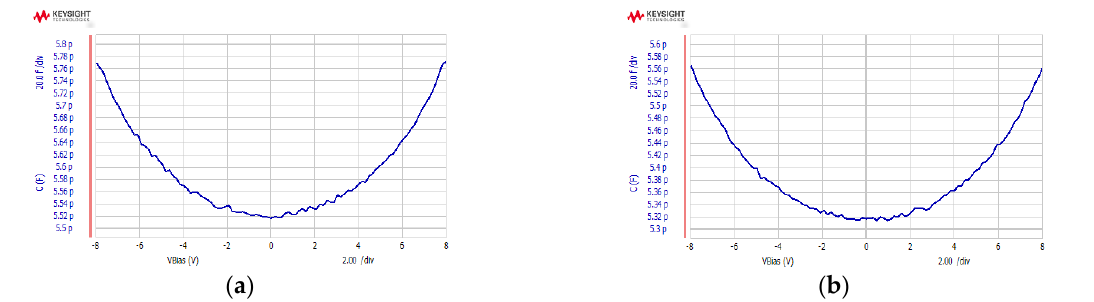
Figure 8. CV characteristics of the accelerometer: ( a ) positive direction; ( b ) negative direction. The capacitance detection was realized through a dedicated ASIC with digital output. The sensitivity of the accelerometer was tested on a centrifuge. The test results showed that the prepared accelerometer had good linearity in the range of plus or minus 2 g. The sensitivity of the accelerometer was 35,459.4 bits/g, and the corresponding sensi- tivity was about 28.2 μg/bit, which had high detection accuracy, as shown in Figure 9.